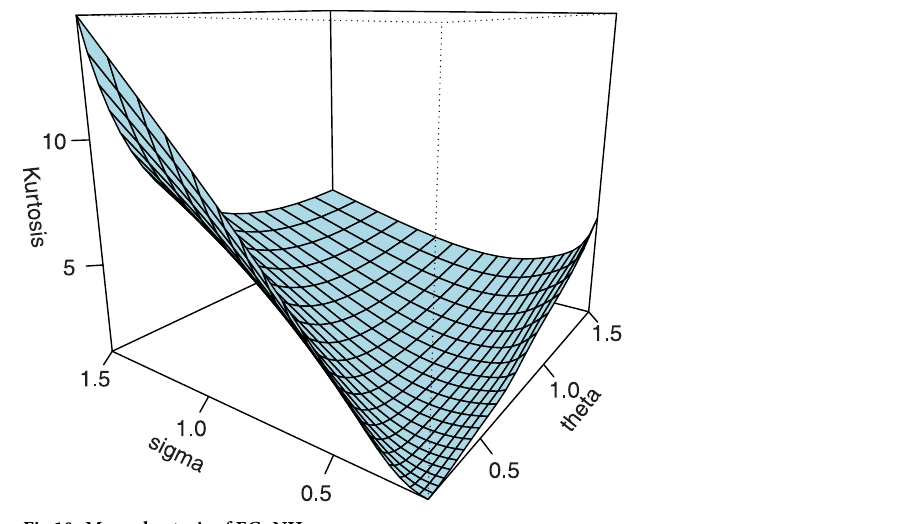
Fig 10. Moors kurtosis of EGuNH.